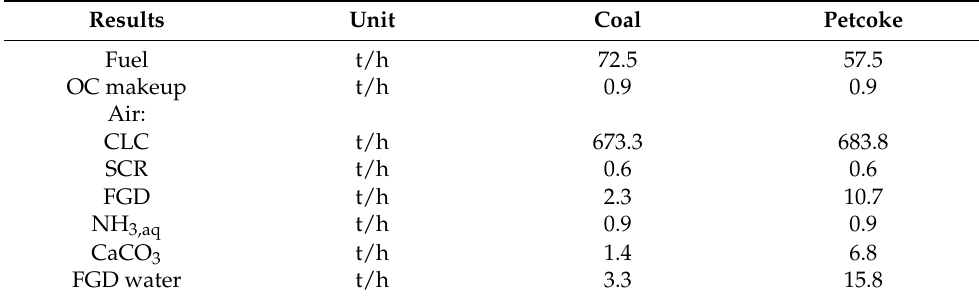
Table 5. Calculated processes